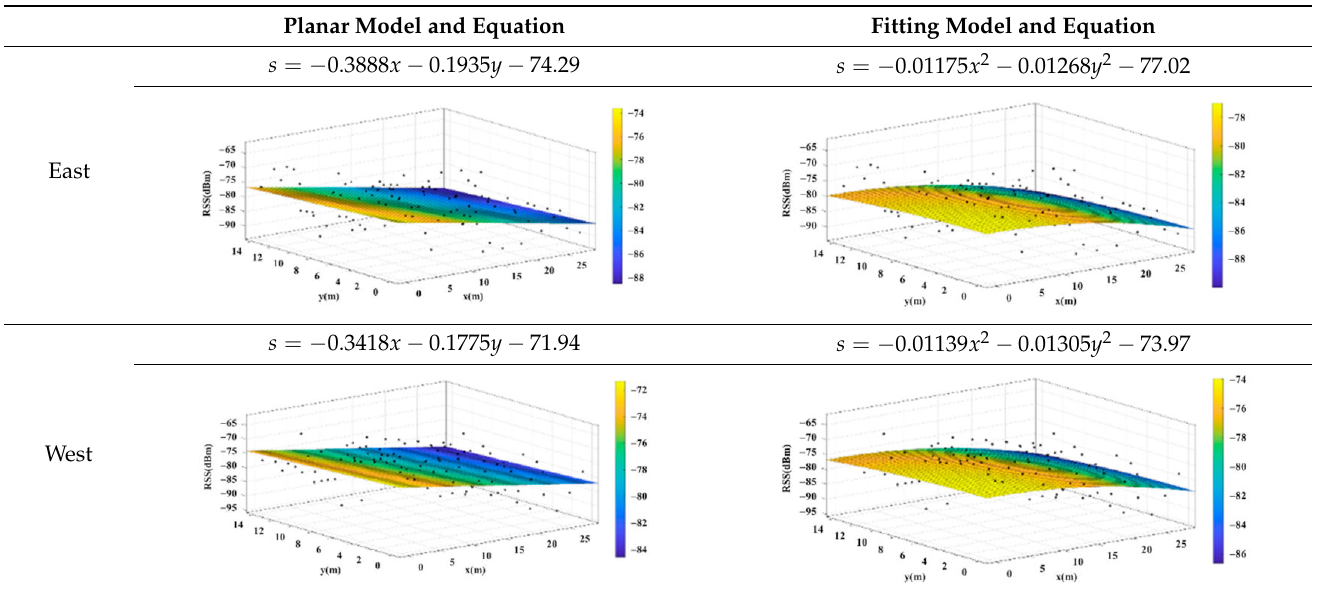
Table 4. Models and Equations Generated from the Four Directions in the Experimental Environment for Base Station